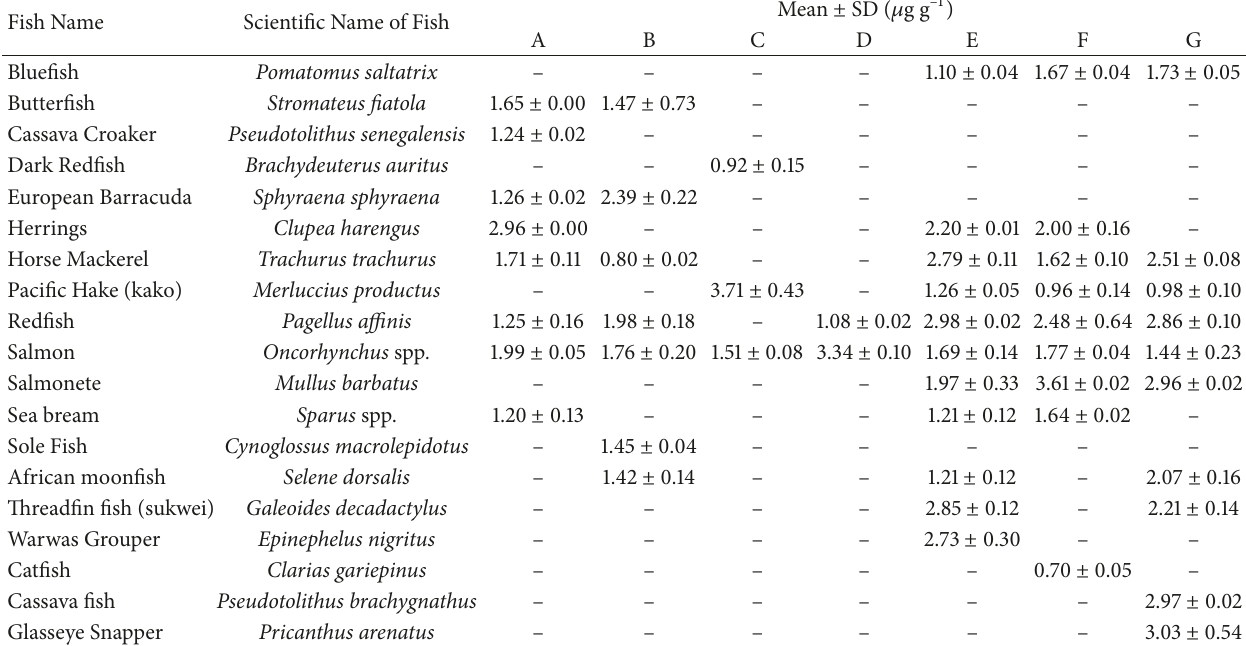
Table 1: Mean FA concentration and standard deviation (SD) in fish from retail and wholesale cold